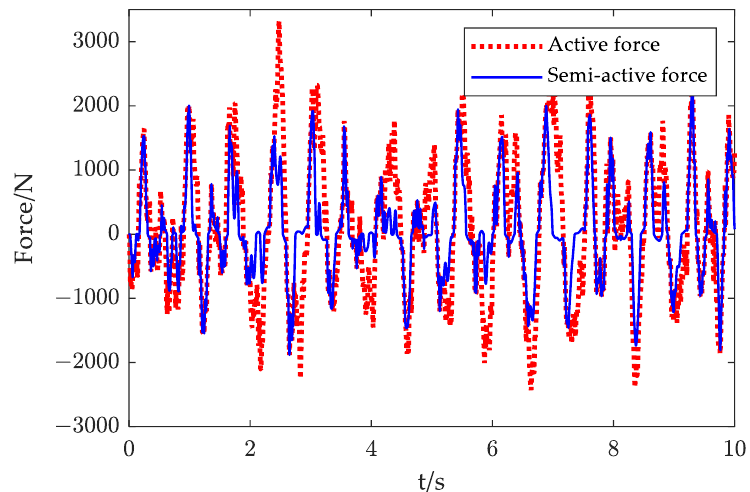
Figure 12. Semi-active force versus active force under random road.